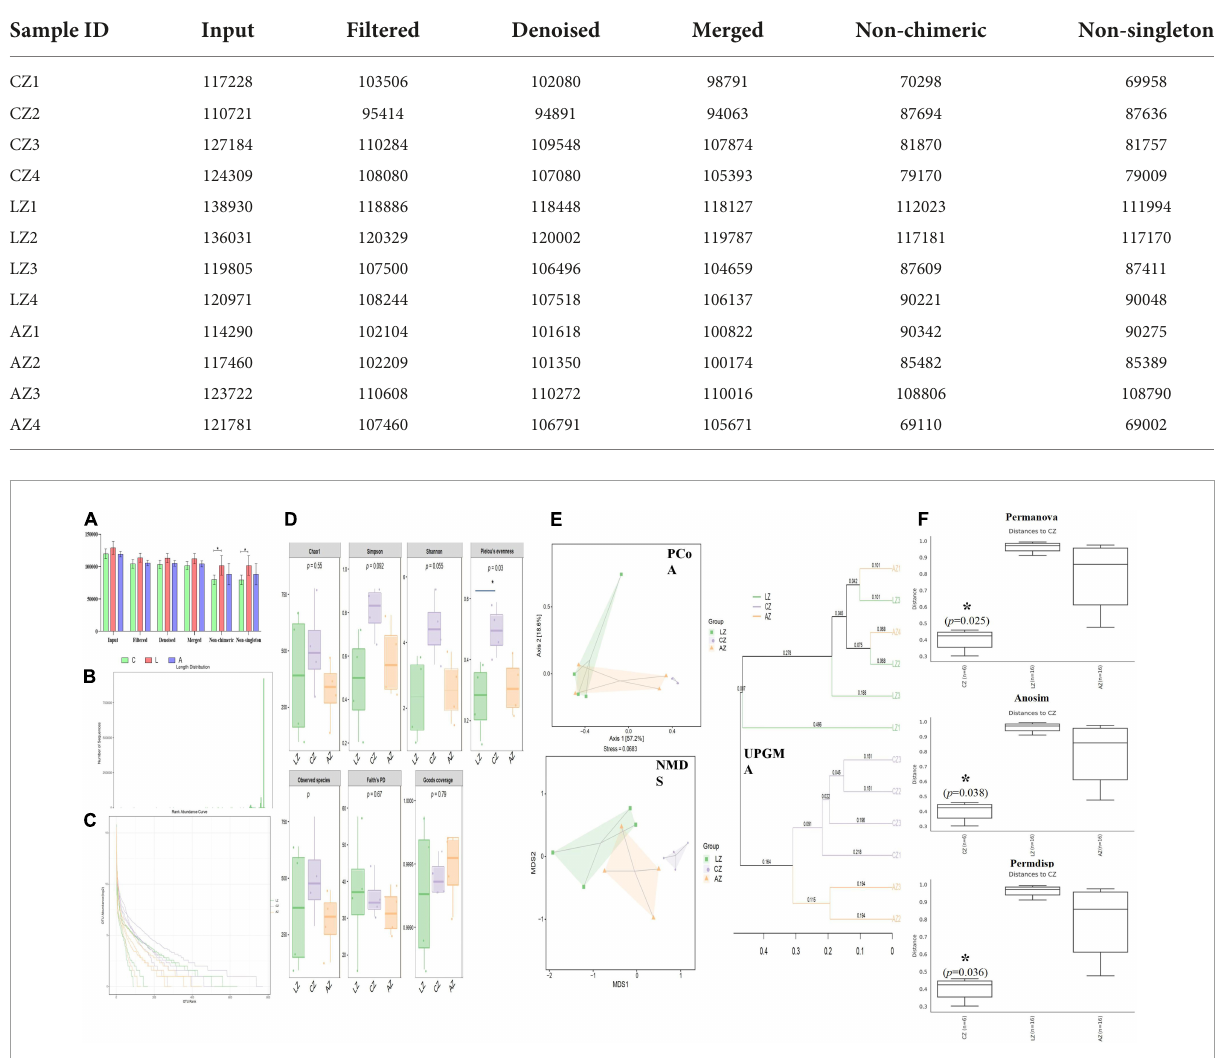
FIGURE4 Sodium acetate/sodium butyrate supplementation restored the structure and diversity of mouse gut microbiota affected by LPS. (A) Sequencing data statistical analysis, (B) length distribution of sequencing data, (C) rank abundance curve, (D) alpha-diversity index analysis, (E) beta diversity analysis, and (F) group difference analysis. Significance is presented as * p < 0.05, ** p < 0.01, *** p < 0.001, and **** p < 0.0001; data are presented as the mean ± SEM ( n =